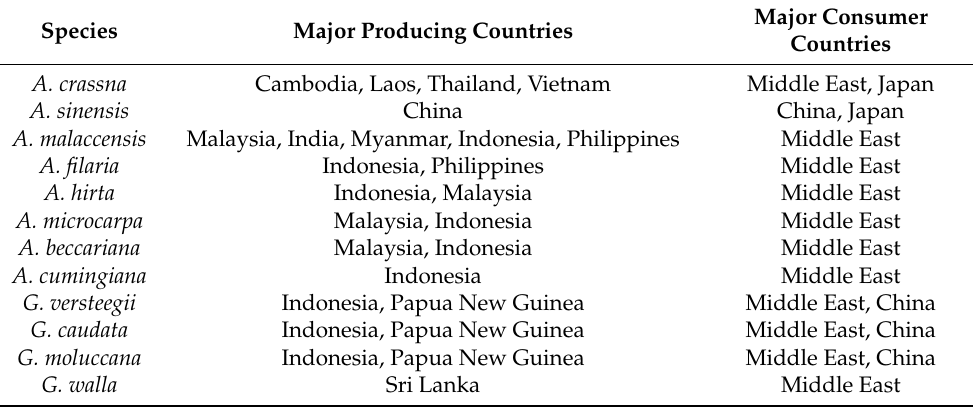
Table 4. Distribution of agarwood producers and